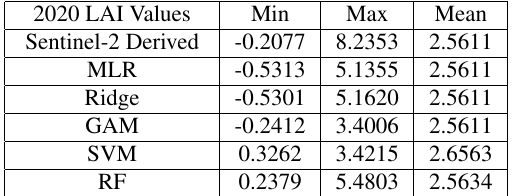
Extremum and mean values were also tabulated for analyz- ing distribution as seen in Tables 1 and 2. From the tables, MLR, ridge and GAM have matched the mean values of the derived since as observed it had concentrated much on the median values. RF model has generated maximum values closest to that of the derived.